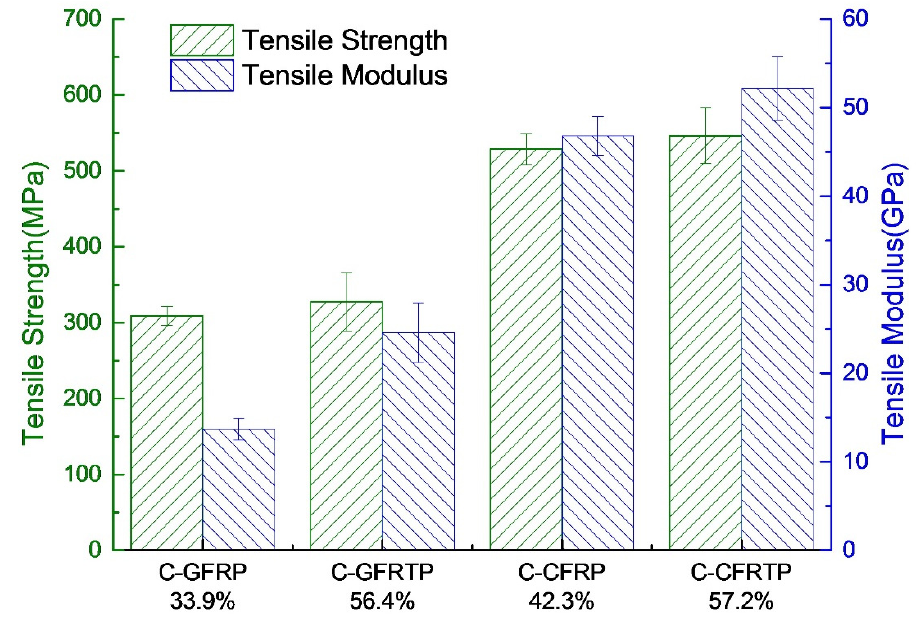
Figure 5. Comparison of tensile property of C-GFRP, C-GFRTP, C-CFRP and C-CFRTP.